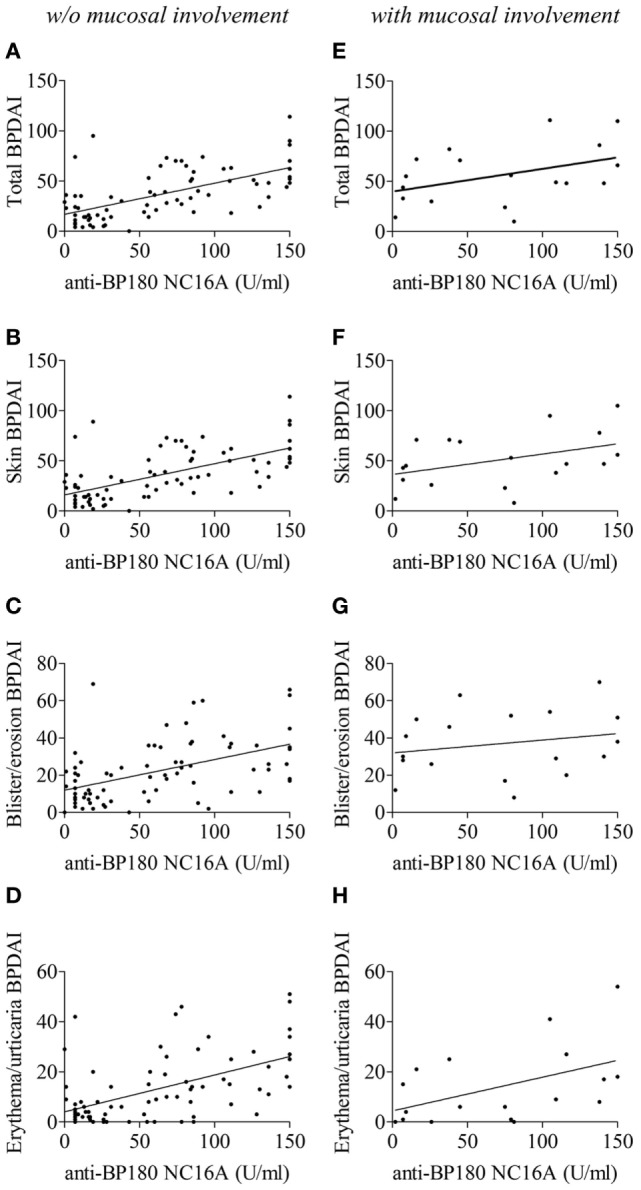
Correlation of serum anti-BP180 NC16A titers with total BP Disease Area Index (BPDAI) (A,E), total skin BPDAI (B,F), blister/erosion BPDAI (C,G), and erythema/urticaria BPDAI (D,H) scores in bullous pemphigoid patients without (A–D) or with (E–H) mucosal involvement. The correlation coefficients and statistical significances were calculated according to Spearman’s correlation test and are summarized in Table 4.